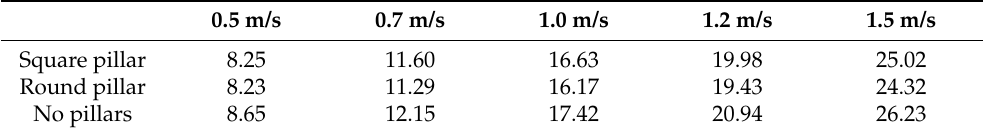
Table 2. Statistical table of subsidence depth unit: mm.